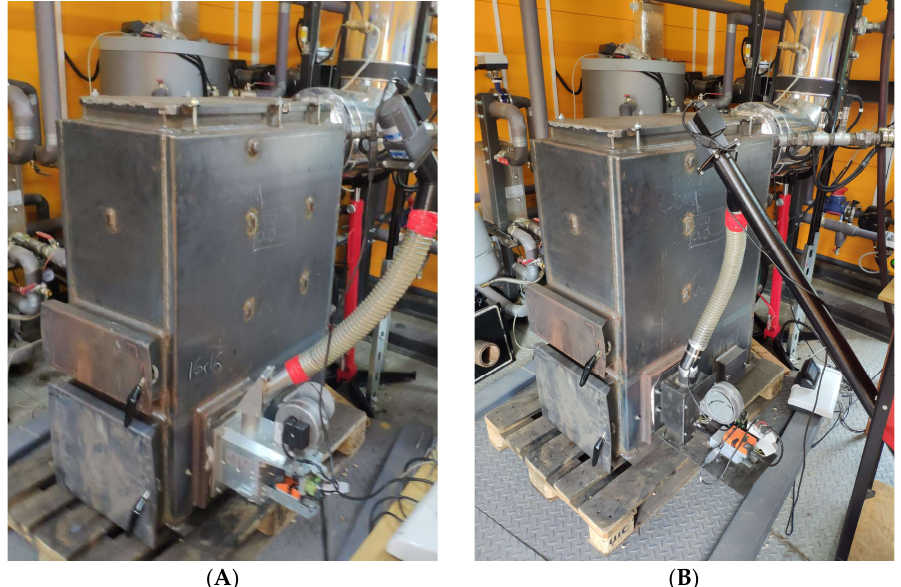
Figure 3. Tested boiler with the moving grate burner ( A ) and with the experimental burner ( B ) on the testing stand.